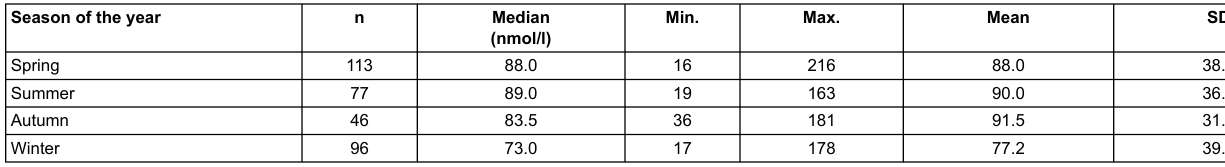
Table 3: 25(OH)D level according to season.